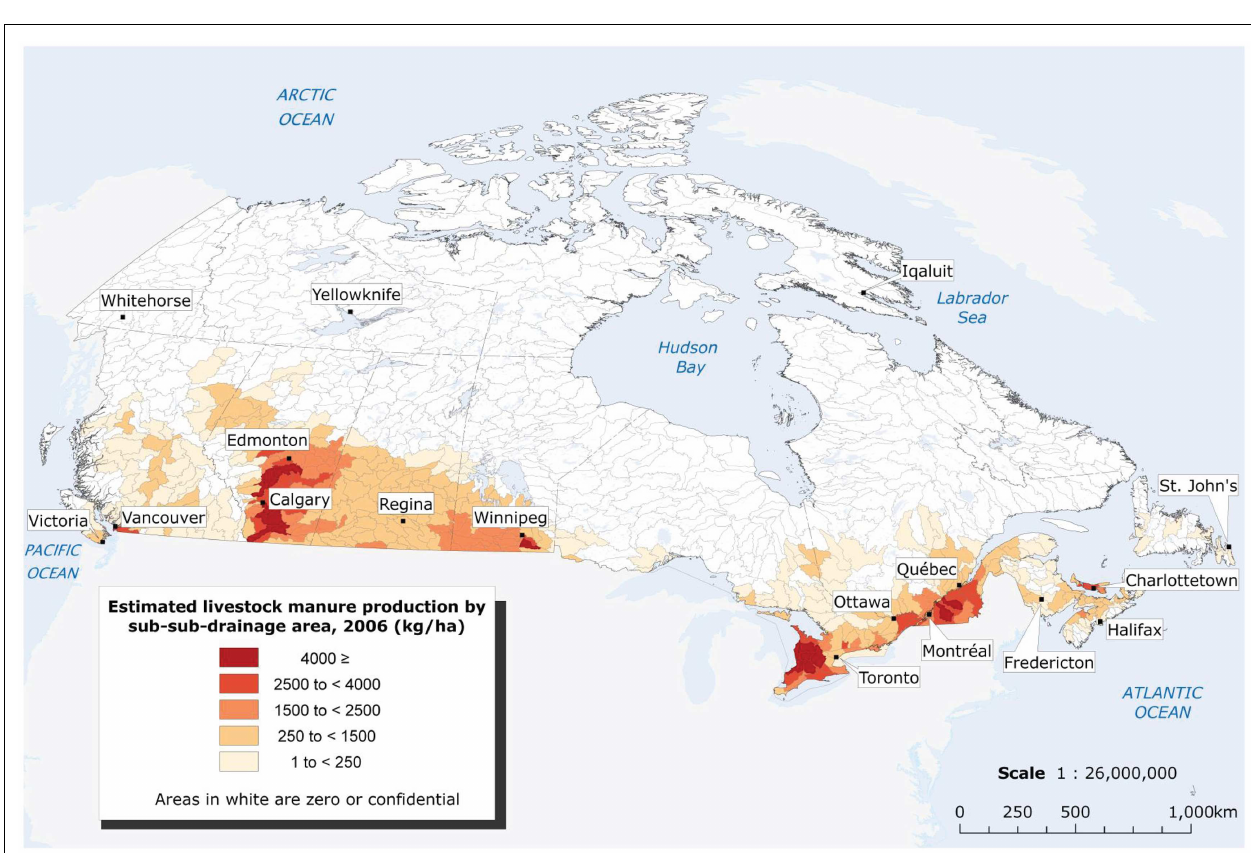
FIGURE 5 |A geographical profile of livestock manure production in Canada (Hofmann, 2006)